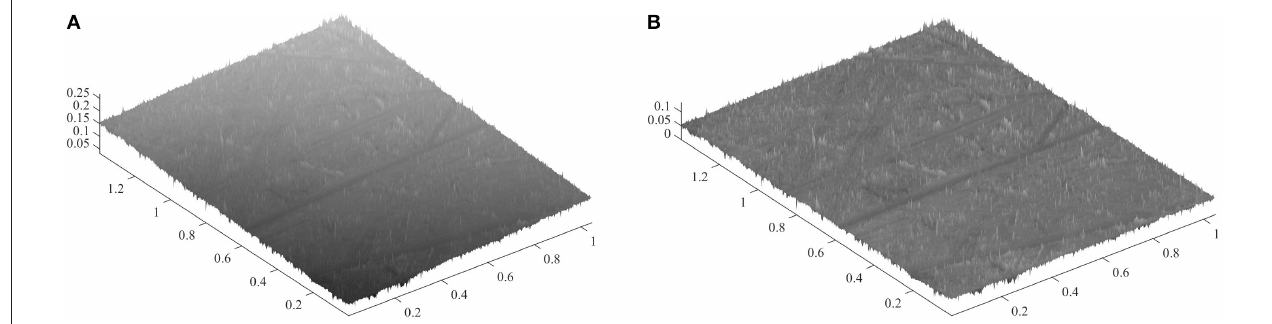
TABLE 1 | Average size of the grains of sandpaper according to standard ISO-6344.